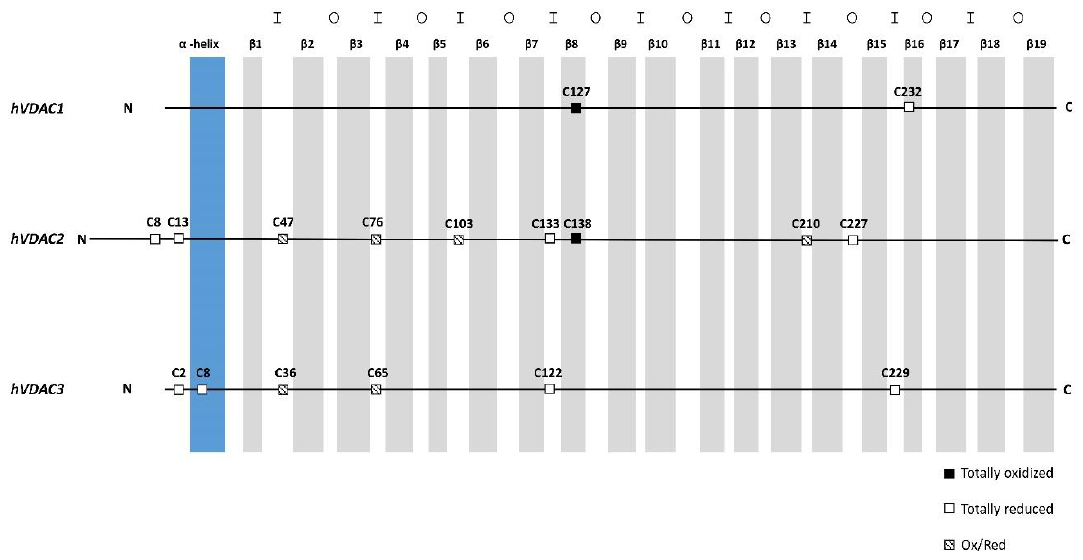
Figure 6. Scheme of the cysteine localization in the aligned sequences of human VDAC isoforms. N-terminal α -helix in blue, β -strands in gray. The internal loops, i.e., exposed to the inter membrane space, are indicated with I. The outer loops, i.e., exposed to the cytosol, are indicated with O. VDAC2 is the longer isoform, with an N-terminal extension of 11 amino acids in mammals. It is